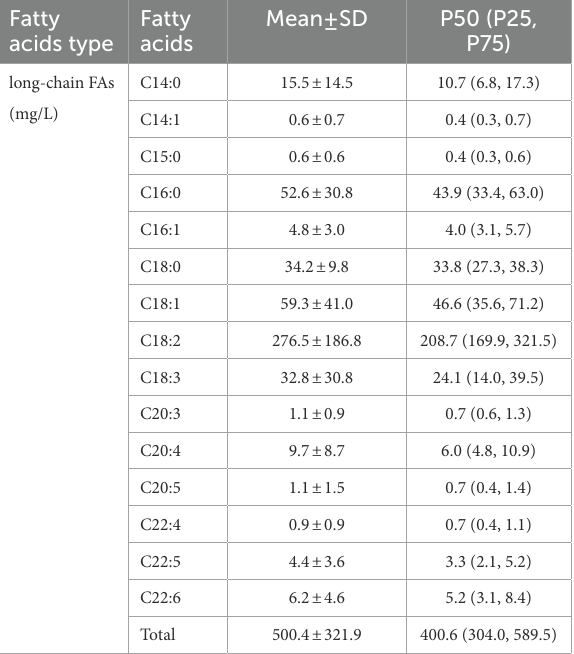
TABLE 3 Contents of long-chain fatty acids in breast